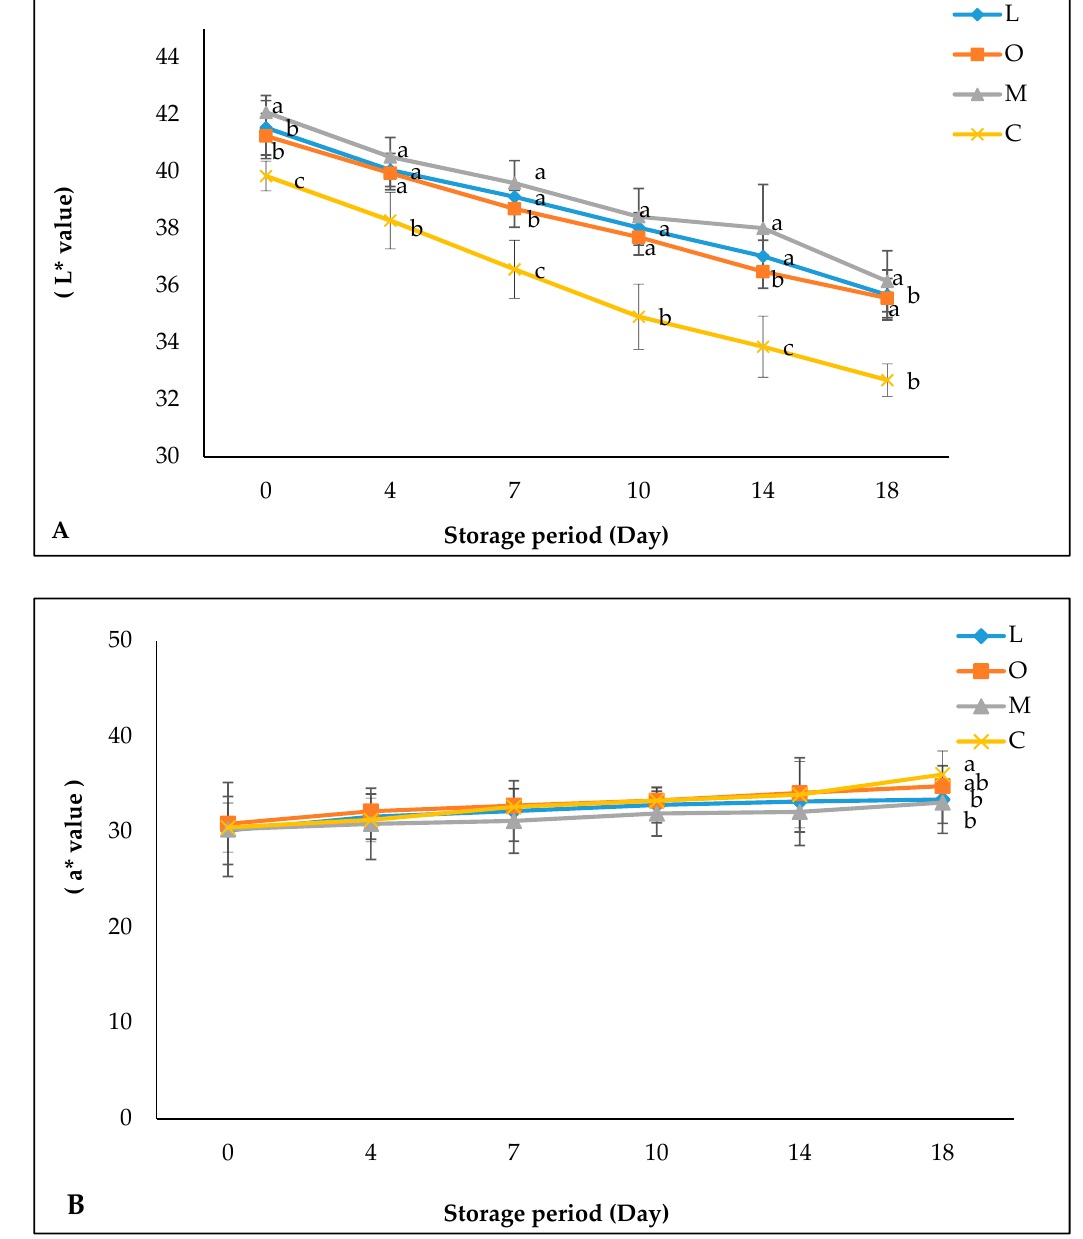
Figure 6. Effect of different essential oil emulsions (L = lemon, O = orange, and M = mandarin essential oil) on color surface of strawberry fruits stored at 2 ◦ C for 18 days. ( A ) = lightness ( L * value) and ( B ) = redness ( a * value). Vertical bars indicate the standard deviation (n = 6). Means and different letters indicate significant difference between treated and control fruits at each storage period (Duncan’s of